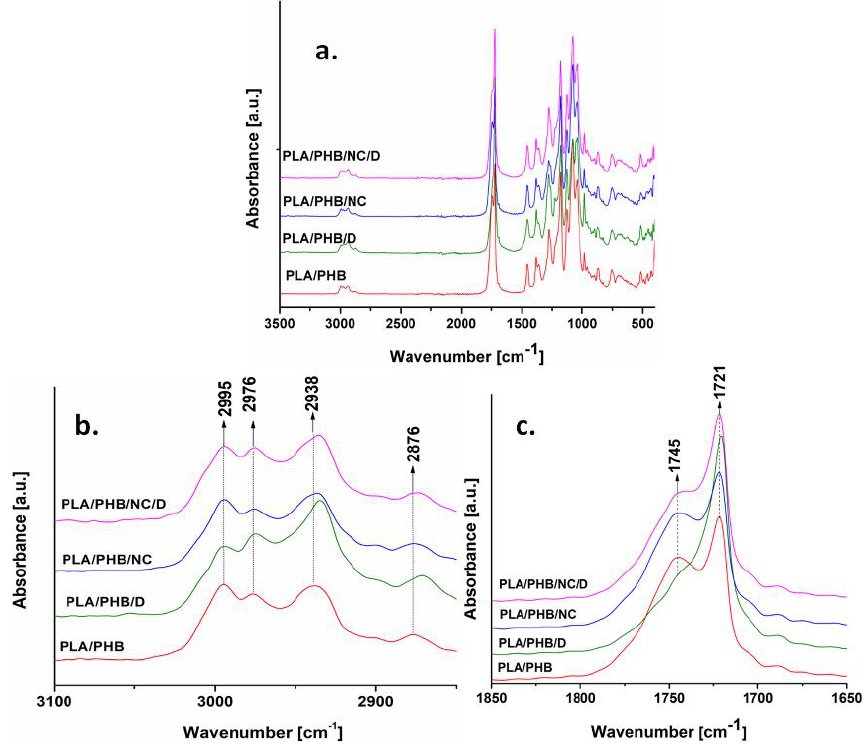
Figure 5. Full ( a ) and detailed ( b , c ) regions of FTIR spectra for PLA / PHB blends and nanocomposites